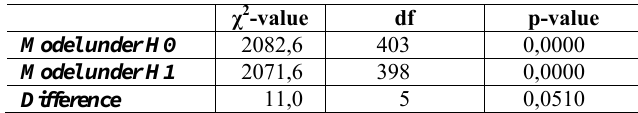
Table 7: Factor variances cross-validation: Chi-square difference test results